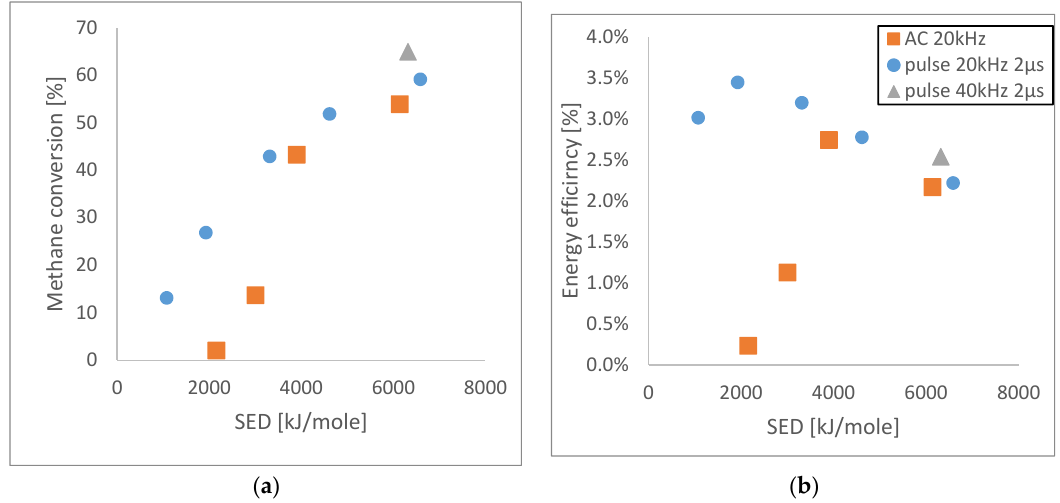
Figure 4. CH 4 conversion ( a ) and energy efficiencies ( b ) in AC and power supply for DRM process in DBD reactor without packing (data adopted from [77] and represented as a function of SED).